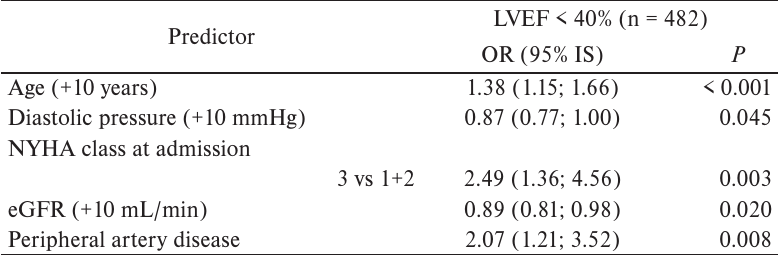
Table 7. Multivariant logistic regression analysis for prediction of 2-year all-cause rehospitalization/mortality of acute heart failure patients after dismissal from the index hospitalization; stratified by the value of left ventricular ejection fraction (HFrEF and HFpEF